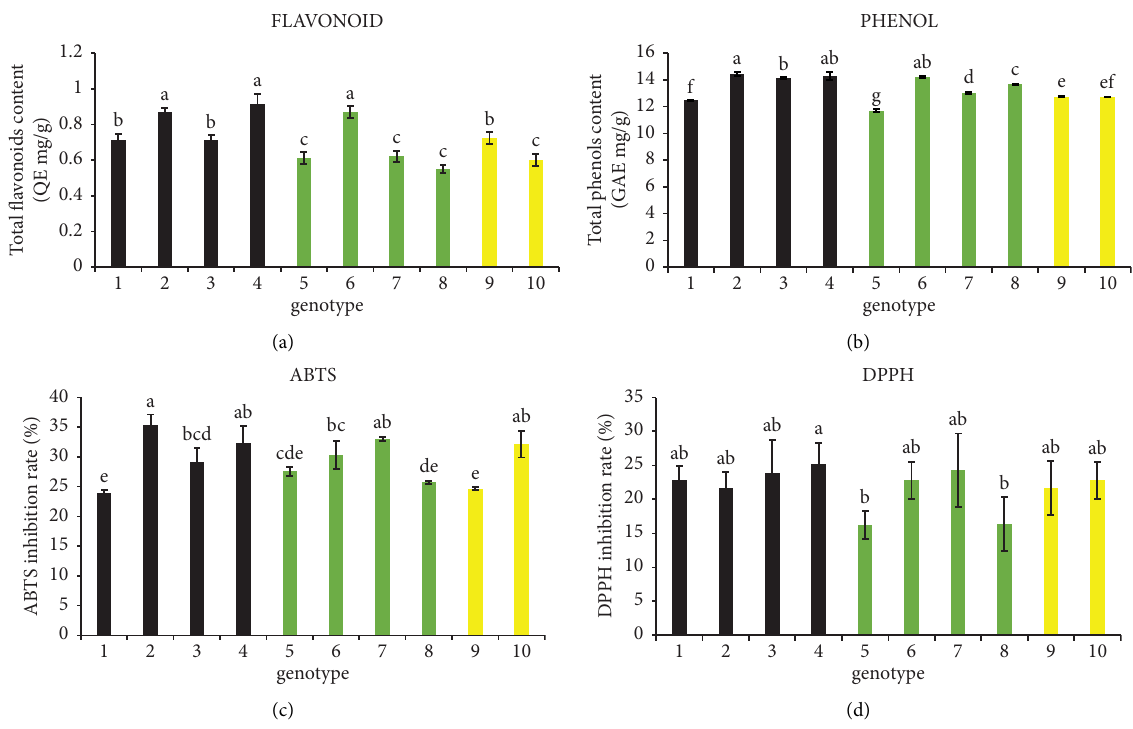
Figure 4: Te content of biochemical compounds and antioxidant activity in mungbean sprouts. (a) Total favonoids, (b) total phenols, (c) ABTS radical scavenging activity, and (d) DPPH radical scavenging activity. Te colors of each bar (black, green, and yellow) indicate the seed coat color. Te error bar indicates the standard deviation. Lowercase letters above the bar indicate statistical signifcance ( p < 0 .